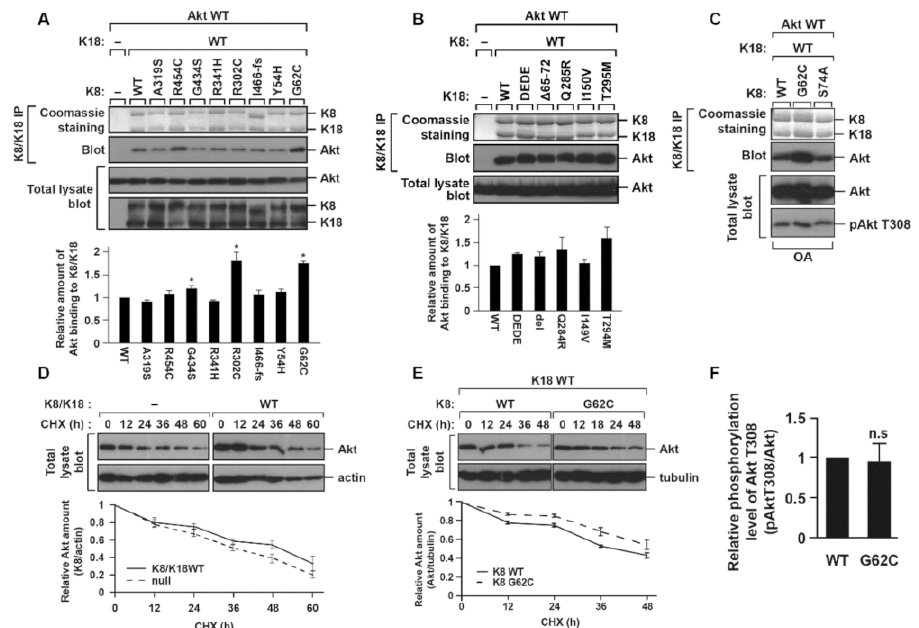
Figure 3. K8 G62C mutation enhanced K8/K18 binding with Akt. ( A ) BHK-21 cells were transfected with Akt, K18 WT, and one of the indicated K8 mutants identified in patients with liver diseases. The cell lysates were immunoprecipitated against K8/K18, and the K8/K18 immunoprecipitates were immunoblotted with antibody against Akt to verify the K8/K18–Akt interaction. The graph represents the means ± S.E. from three independent experiments. * indicates p < 0.05. ( B ) BHK-21 cells were transfected with Akt, K8 WT, and one of the indicated K18 mutants found in patients with liver diseases or the caspase-resistant mutant. The K18 D238/396E (DEDE) mutant is resistant to caspase-induced K18 cleavage. The K8/K18 immunoprecipitates were prepared and immunoblotted as described in panel A. The graph represents the means ± S.E. of three independent experiments. ( C ) BHK-21 cells were transfected with Akt WT, K18 WT, and one of K8 constructs (K8 WT, K8 G62C, or K8 S74 phospho-deficient mutant (K8 S74A). The cells were treated with OA, and then K8/K18 immunoprecipitates and total lysates were immunoblotted with antibody to the indicated epitopes. ( D ) BHK-21 cells or transfected BHK-21 cells with K8/K18 WT were treated with cycloheximide (CHX). The cells were harvested after 12, 24, 36, 48, and 60 h, and the cell lysates were immunoblotted with antibody against Akt or actin. The graph represents the means ± S.E. of three independent experiments. ( E ) BHK-21 cells were transfected with Akt WT, K18 WT, and one of K8 WT or K8 G62C.